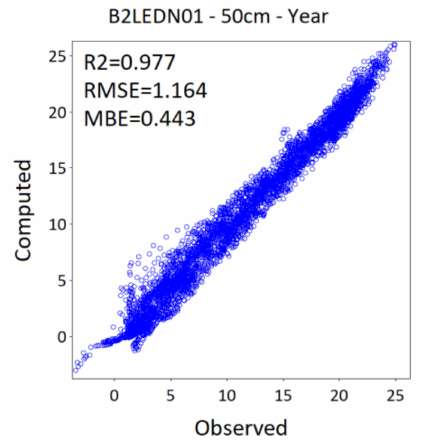
Figure A4. Validation at site B2LEDN01 for 50 cm soil depth.